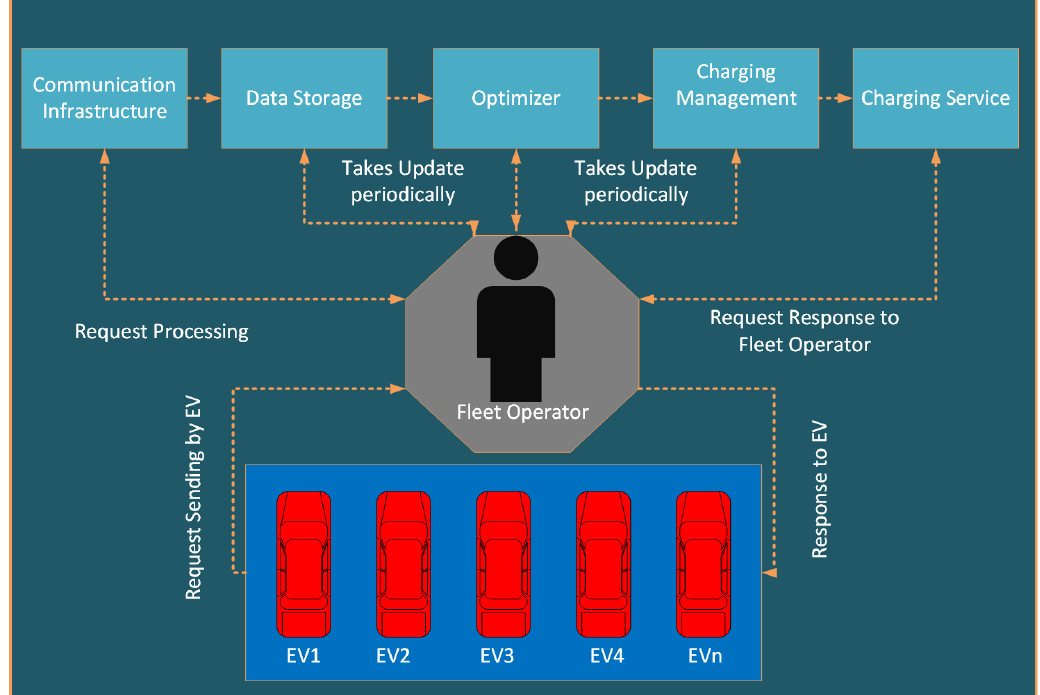
Figure 7. Fleet Operator and